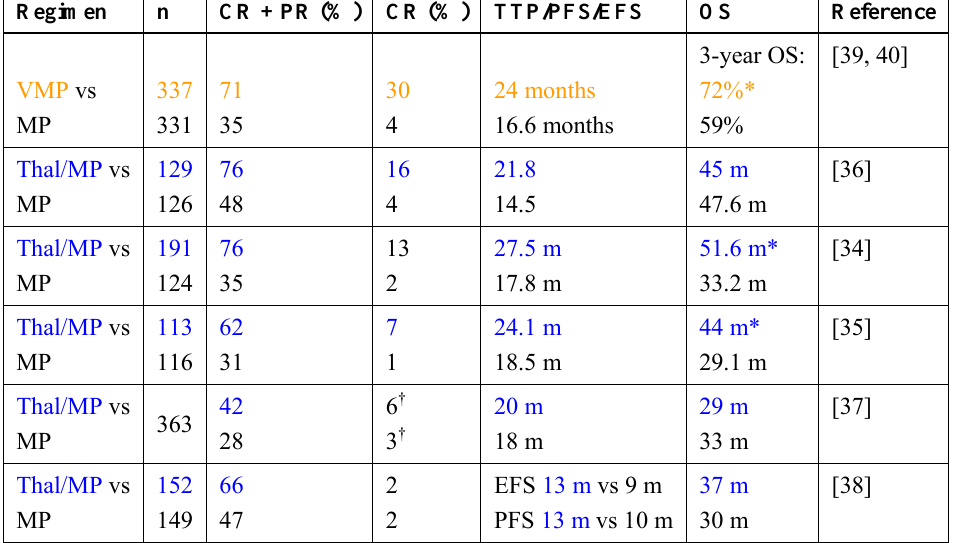
Summary of phase III data for recommended regimens in front-line non-transplant setting: MPT and VMP.